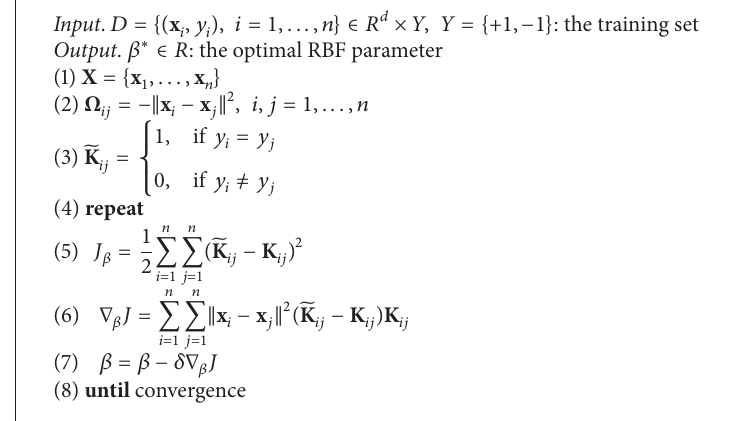
Algorithm 1: Gradient descent algorithm for obtaining the optimal RBF parameter.